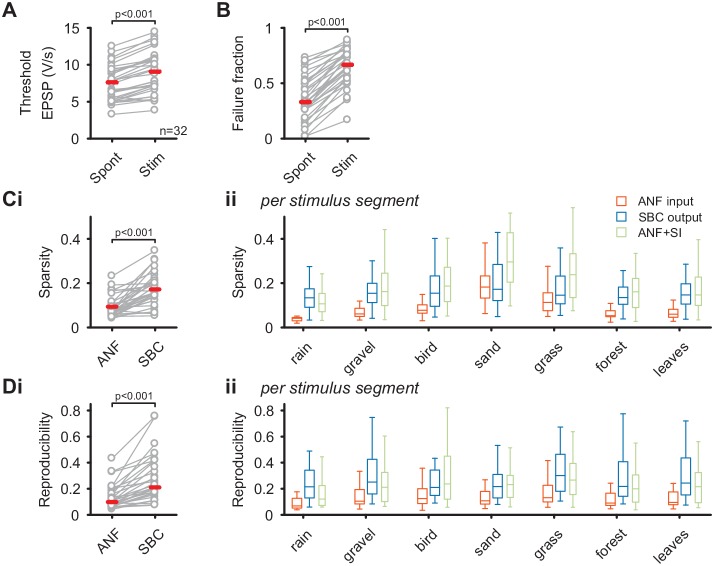
SBC output exhibits increased sparsity and reproducibility compared to ANF input which can be attributed to activity-dependent subtractive inhibition.(A) During acoustic stimulation the threshold EPSP for AP generation (left) was increased and consequently so was the failure fraction (right), indicating strong inhibition during acoustic stimulation with natural sounds. (B) (i) The sparsity of the neuronal response was separately calculated for the ANF input and the SBC output. The SBC output showed consistently higher sparsity than the ANF input. (ii) The increase in sparsity from the ANF input (orange) to the SBC output (blue) was consistently observed for the different stimulus segments. Simulated (subtractive) inhibition (ANF +SI, green) resulted in similar increases in sparsity. Notably, for conditions in which the sparsity of the ANF input was high (i.e. 'sand'), the SBC output did not increase further. (C) (i) Similar to sparsity, the reproducibility of the neuronal response increased at the SBC level. (ii) Again, this effect was consistent for the different stimulus segments and well approximated by simulating subtractive inhibition.10.7554/eLife.29639.007Figure 2—source data 1.Threshold EPSP (in V/s) and failure fraction during acoustic spontaneous activity and natural acoustic stimulation.Values of sparsity and reproducibility for ANF input and SBC output for both the complete stimulus and separated in stimulus segments.